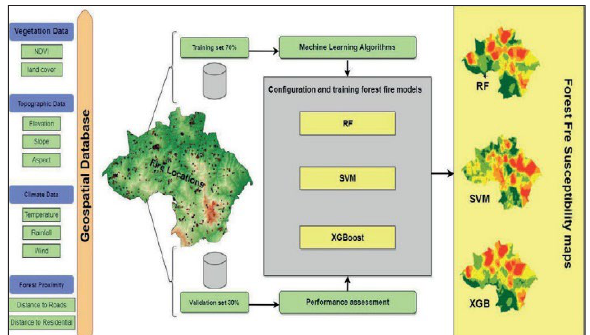
Figure. 5. Workflow of the methodology employed in this